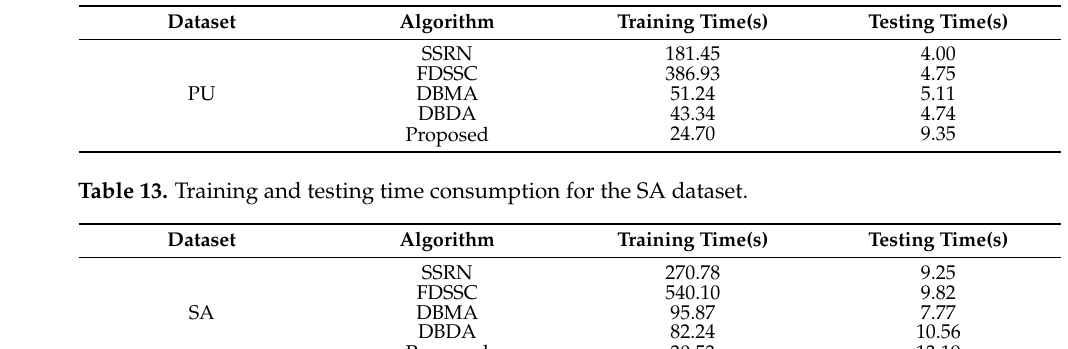
Table 12. Training and testing time consumption for the PU dataset.